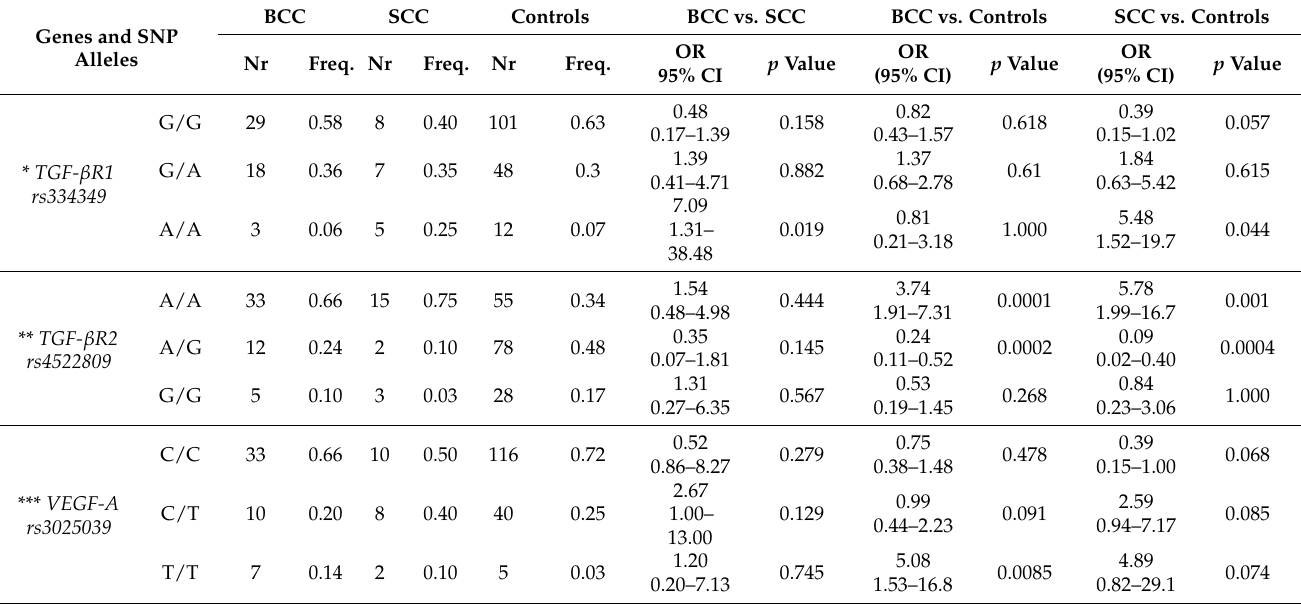
Table 6. Significantly different SNP frequencies in non melanocitic skin cancer patients (NMSC) affected by basal cell carcinoma (BCC) compared to NMSC with squamous cell carcinoma (SCC) (adjusted by 64 years age cut off and